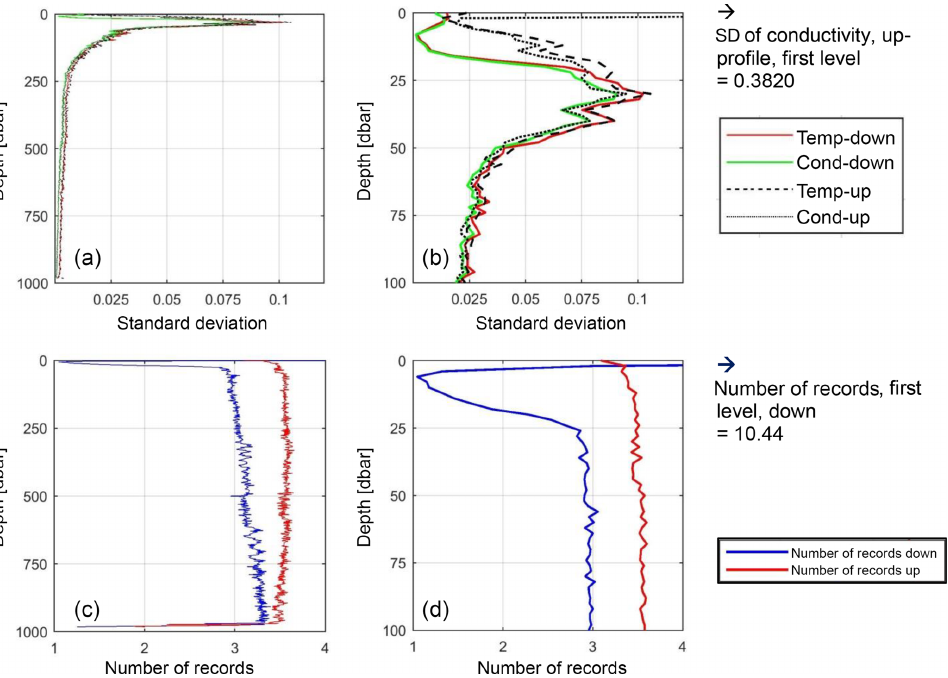
Figure 5. Standard deviation (a, b) and number of original data (c, d) for 2dbar averages of temperature and conductivity are shown for the down- and upcasts. Glider 127 during the mission in 2015 was used as an example. The whole depth range of the profiles is shown in (a, c) , only the upper 100dbar in (b, d) . Extreme values at the surface and the legend for the figures to the left are given in the right